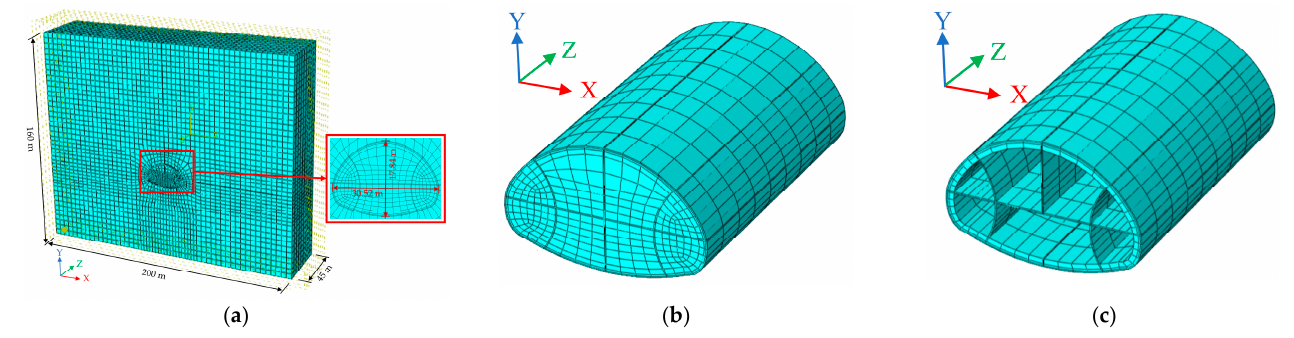
Figure 3. The numerical calculation model: ( a ) The whole calculation model; ( b ) Tunnel excavation rock mass; and ( c ) Tunnel lining.